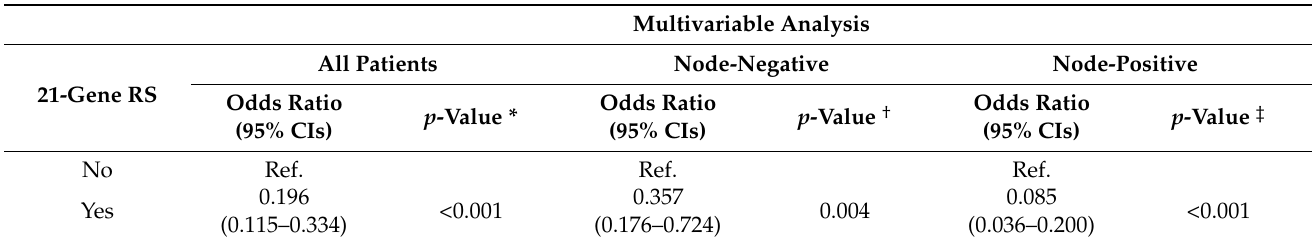
Table 2. Adjusted odds ratios (ORs) and 95% confidential intervals (CIs) of 21-gene RS for the implementation of chemother- apy in patients with high clinical risk among the entire cohort.